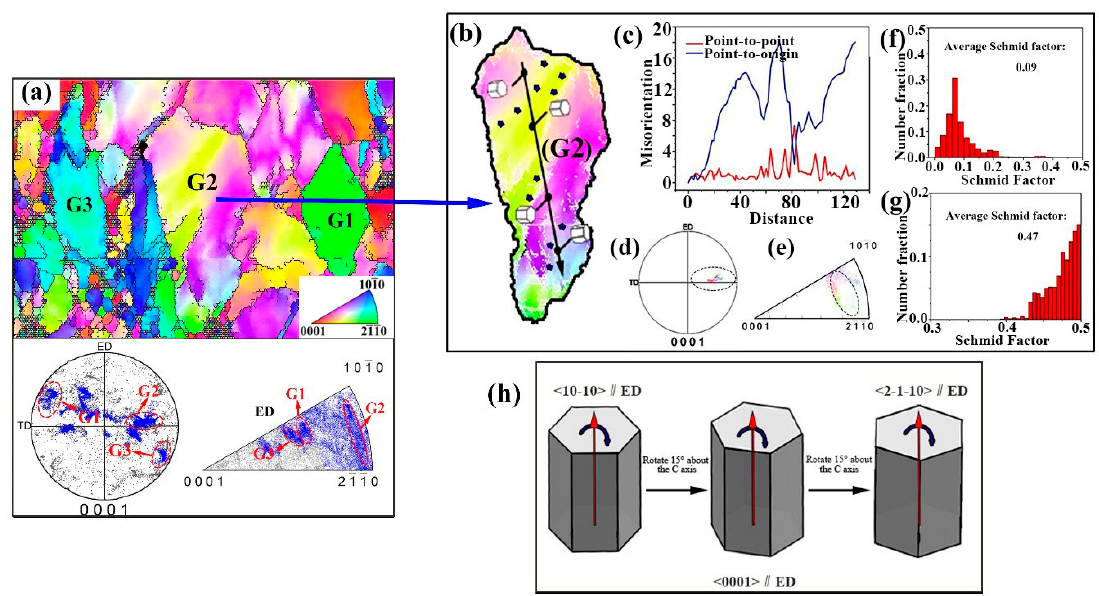
Figure 9. IPF coloring map and corresponding (0001) PF and IPF after 1 pass ( a ). The OIM diagram of grain G2 ( b ) and the corresponding line graph of misorientation angle along the AB ( c ), PF ( d ), IPF ( e ), Schmid factor (SF) graph of basal plane ( f ), SF graph of prismatic plane ( g ) in ( b ); schematic diagram of prismatic slip ( h ).